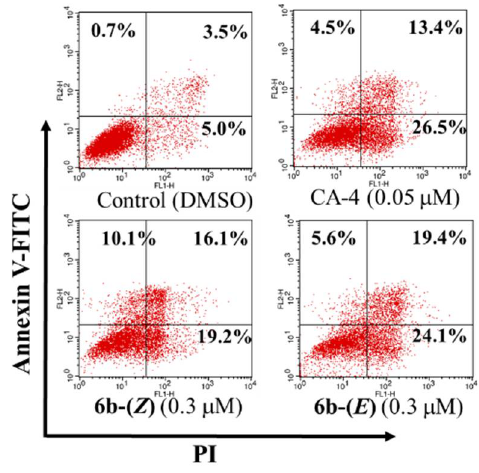
Figure 3. Induction of apoptosis by 6b-( Z ) , 6b-( E ) and CA-4 at the indicated concentrations on HepG-2 cells. After treatment for 48 h, the cells were stained with PI and Annexin V-FITC and viable, apoptotic and necrotic cells were analyzed by flow cytometry. Cells in lower left quadrants are alive, in the lower right quadrants are in early apoptosis, in the upper right quadrants are in late apoptosis and in the upper left quadrants are necrotic. Percentage of the total signal within the quadrant is indicated. Each experiment was performed in triplicate.